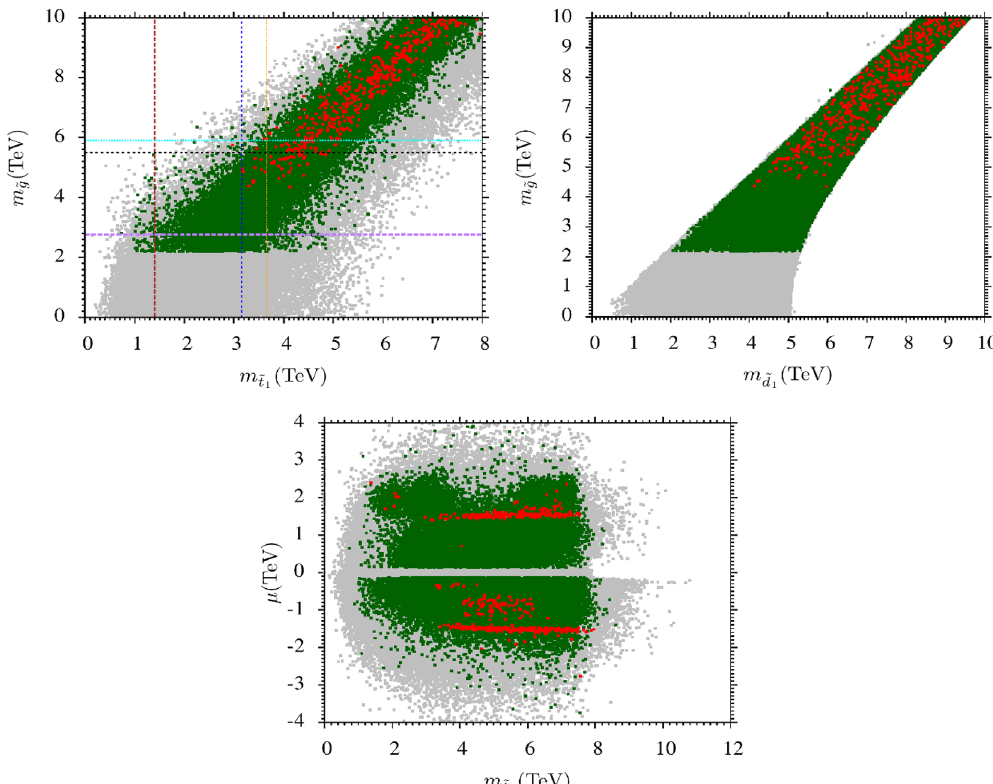
Figure 1 . Grey points satisfy the REWSB and the LSP neutralino conditions. Green points satisfy the mass bounds and B-physics constraints. Red points form a subset of green points and satisfy Planck 2018 bounds on the relic abundance of the LSP neutralino within 5 σ uncertainty. They are consistent with the current dark matter direct detection bounds presented by LUX. See text for the description of dashed horizontal and vertical lines in left